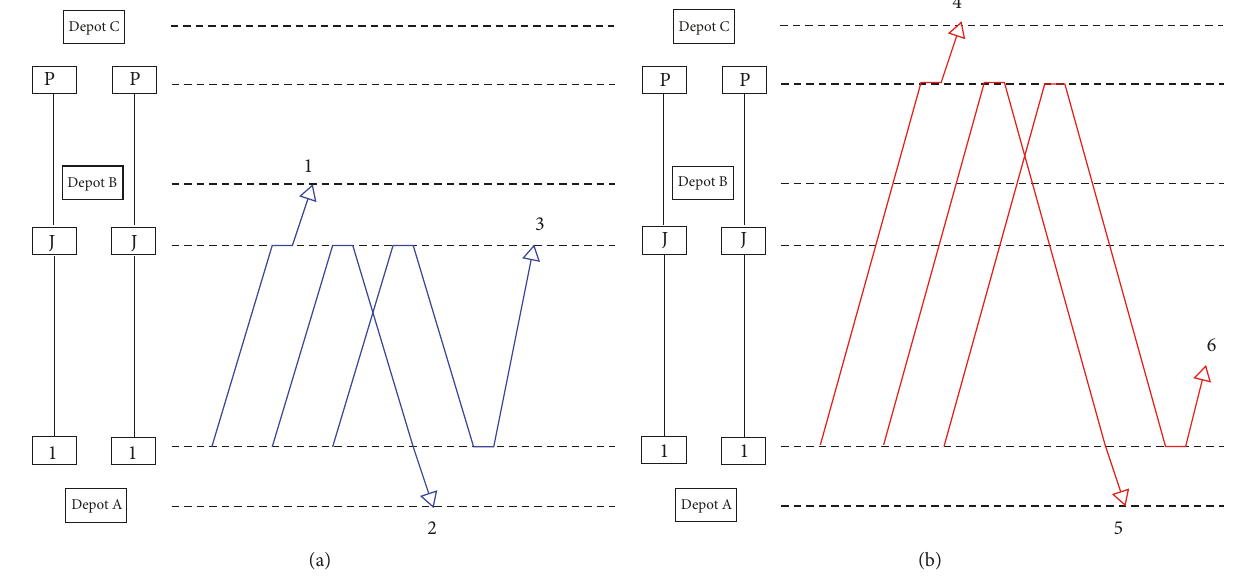
Figure 3: Possible situations for operations of train services in the up direction.